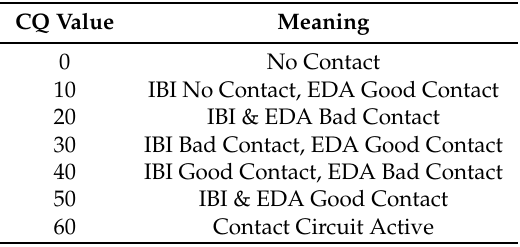
Table 1. CQ (contact quality) Value Definition; IBI: Inter-Beat Interval; EDA: Electro Dermal